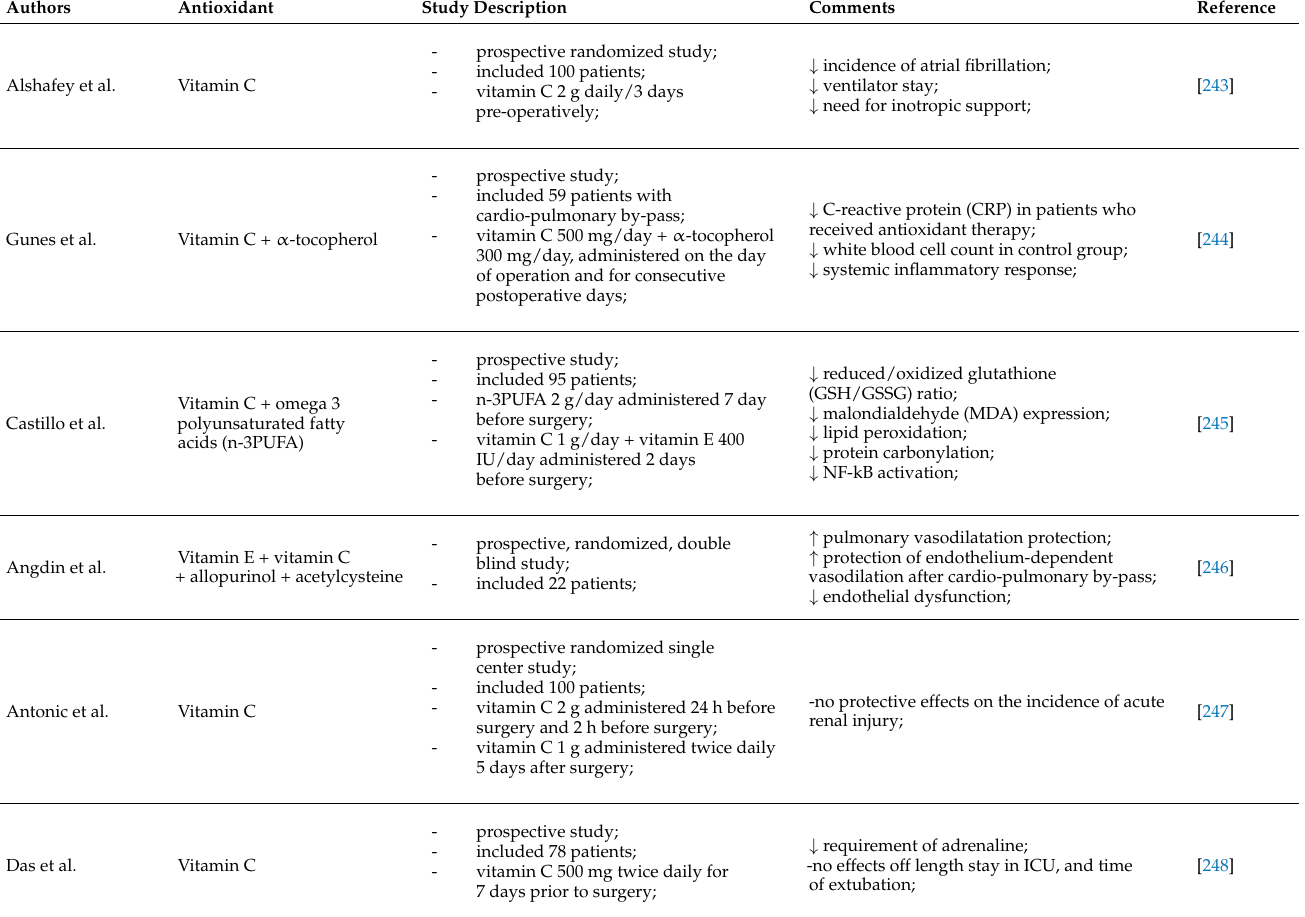
Table 2. Impact of perioperative antioxidant therapy on clinical outcomes in